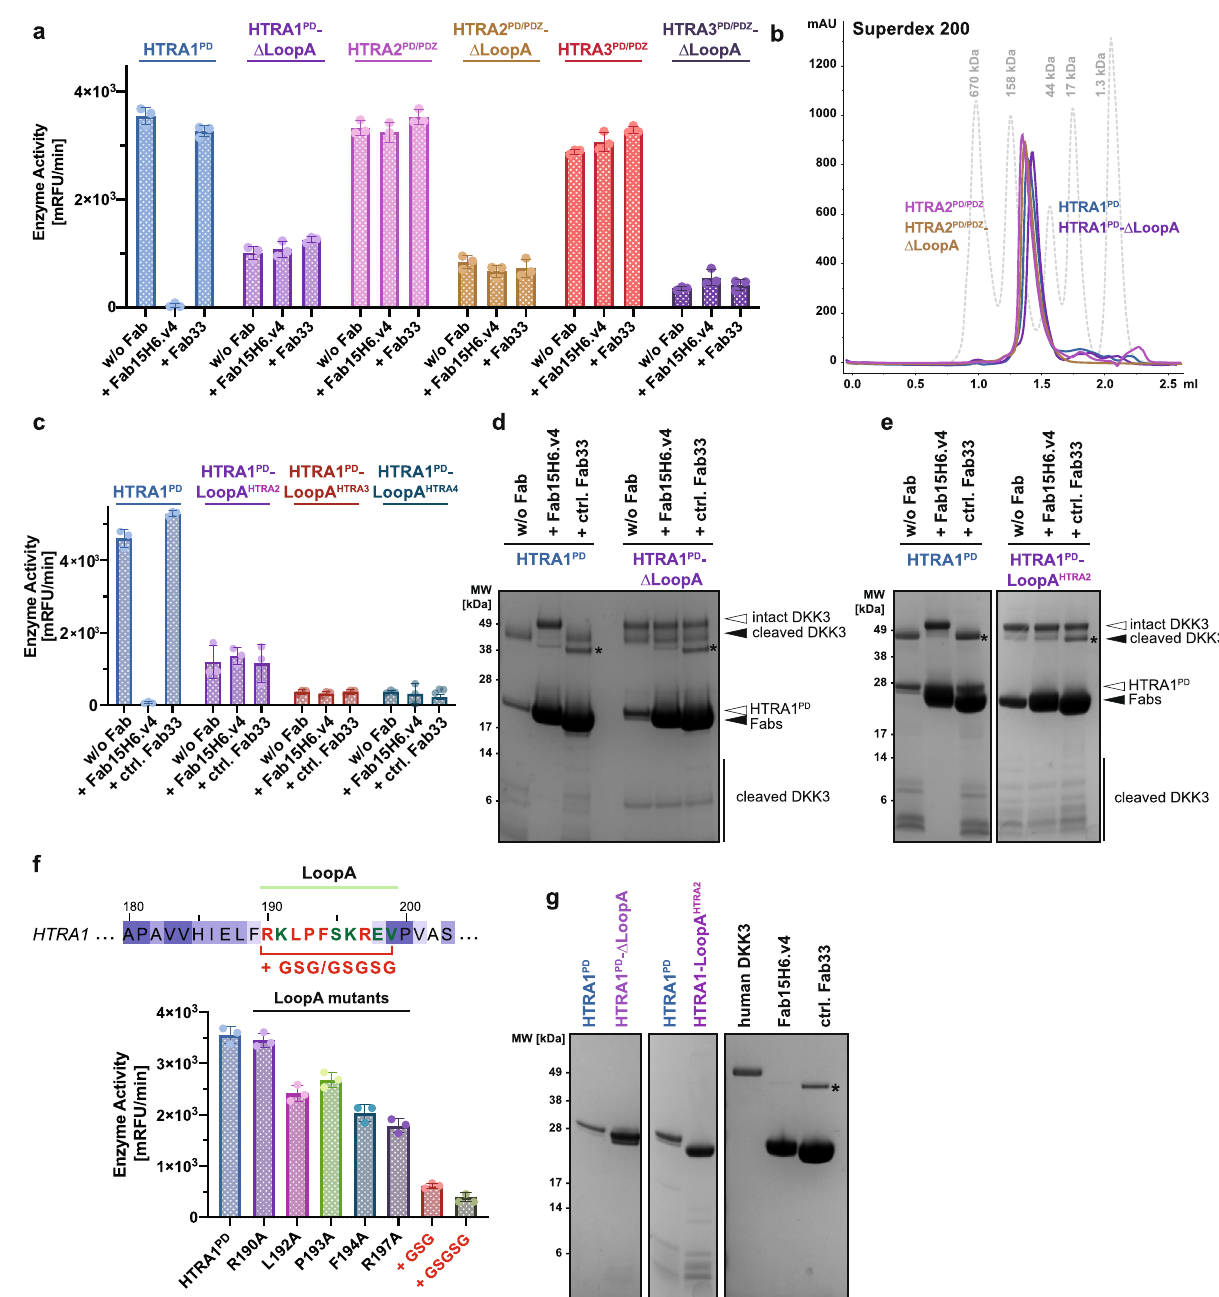
Fig. 5 | Deletion or perturbation of LoopA diminishes catalytic activity within the HTRA family. a Enzymatic activity of wildtype HTRA1 PD , HTRA2 PD/PDZ , and HTRA3 PD/PDZ compared to their Δ LoopA mutants; Fab15H6.v4 and the control Fab33 did not modify the mutant activities. b Size-exclusion chromatography pro fi les of HTRA1 PD (blue), HTRA1 PD - Δ LoopA (purple), HTRA2 PD/PDZ (light purple) and HTRA2 PD/PDZ - Δ LoopA (brown) indicate formation of trimers (protein stan- dardsingrey). c EnzymaticactivityofLoopAchimerasofHTRA1 PD inthepresence or absence of Fab15H6.v4. d In-vitro DKK3 cleavage assay using puri fi ed HTRA1 PD or HTRA1 PD - Δ Loop mutant in the presence or absence of Fab15H6.v4. e In-vitro DKK3 cleavage assay using wildtype HTRA1 PD and the LoopA swap chimera